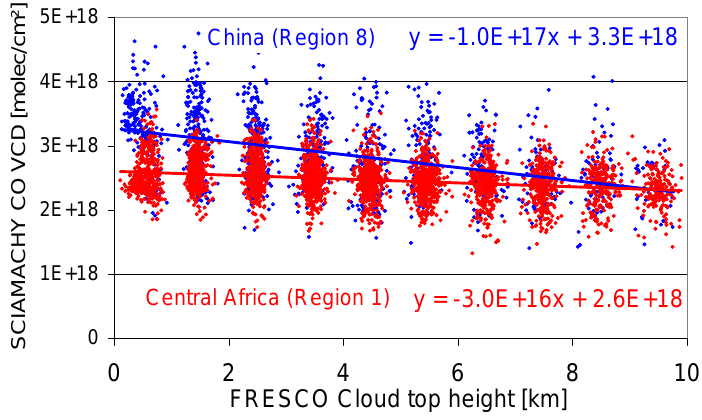
Fig. A3 Dependence of the CO VCD on the cloud top height (FRESCO) for effective cloud Fig. A3. Dependence of the CO VCD on the cloud top height (FRESCO) for effective cloud fractions < 20%. Measurements for January to fractions <20%. Measurements for January to March 2004 – 2005. March 2004–2005.